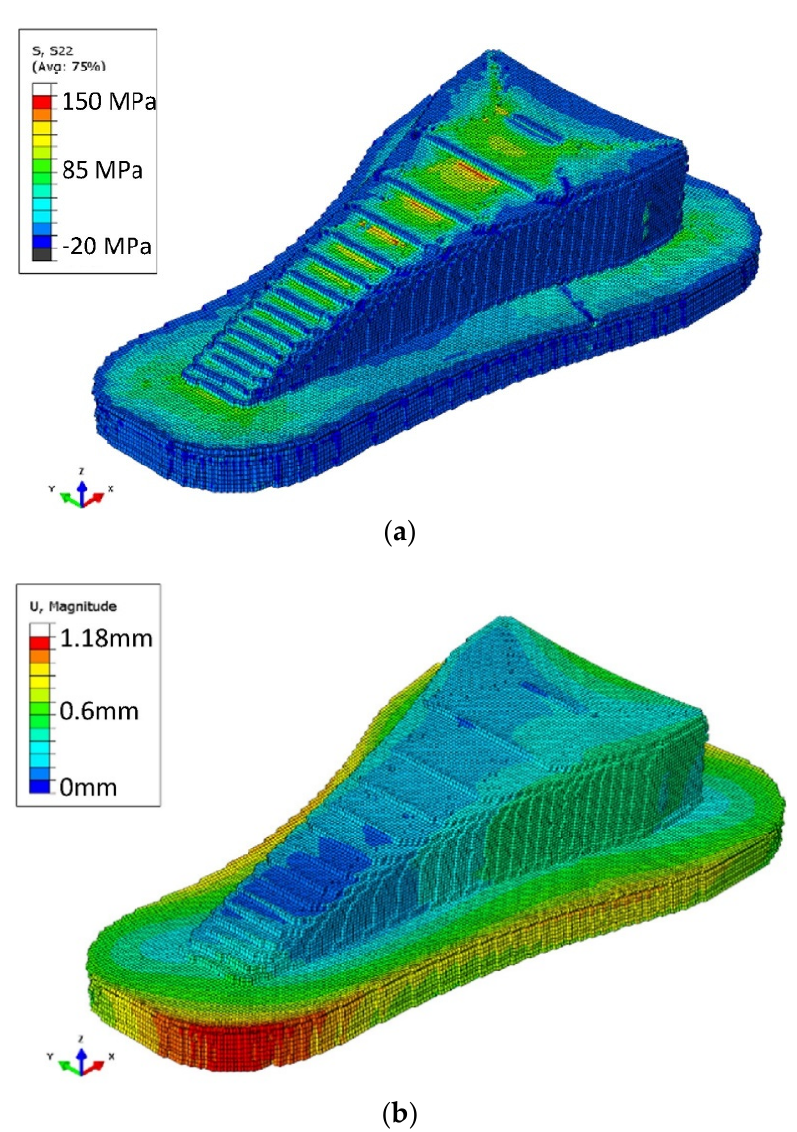
Figure 8. ( a ) Stresses in 3D printed polymer composite part after cooling down ( b ) warpage (exag- gerated at a scale of 10). Reprinted with permission from reference [20]. Copyright 2018, Elsevier.